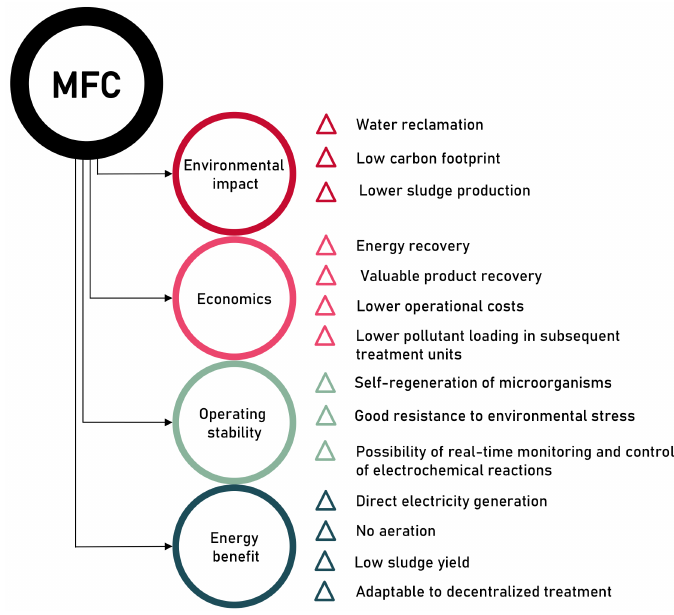
Figure 2. Potential benefits of MFCs for energy, environmental, operational, and economic